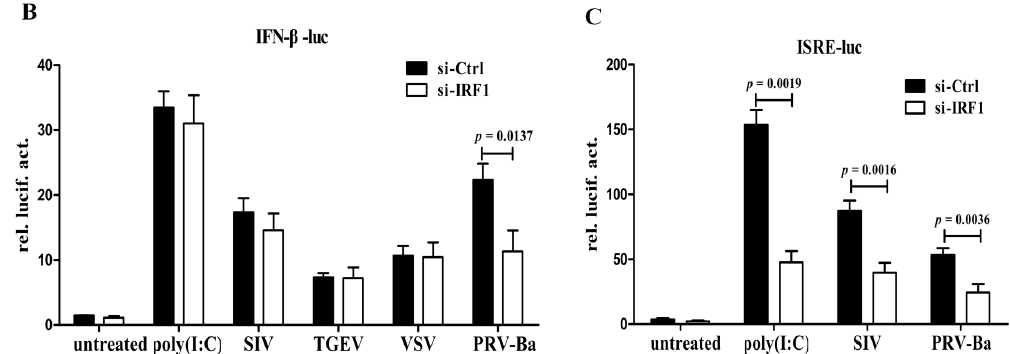
Figure 4. poIRF1 might be dispensable for IFN- β induction triggered by RNA viruses but essential for the activation of ISRE. ( A ) The effect of poIRF1 overexpression on activation of IFN- β and ISRE promoter. PK-15/PB and PK-15/IRF1 cells were cotransfected with indicated promoter constructs (0.5 µg) and pRL-TK (0.025 µg). At 24 h post-transfection, cells were transfected with poly(I:C) for another 24 h or left untreated and then harvested for detection of IFN- β and ISRE promoter activity. For measuring poIRF1-mediated induction of IFN- β , RT-qPCR was used to detect the transcription of endogenous IFN- β .The relative expression was normalized to the expression of GAPDH and expressed as fold induction relative to the expression level in control cells. Error bars represent SDs, which were obtained by measuring each sample in triplicate; ( B , C ) The effect of poIRF1 knockdown on activation of IFN- β and ISRE promoter. PK-15 cells were transfected with si-IRF1 or si-Ctrl for 36 h. Then, cells were cotransfected with IFN- β -luc or ISRE-luc and pRL-TK. At 24 h post-transfection, cells were transfected with poly(I:C) or infected with indicated viruses for another 12 h or left untreated and then harvested for detection promoter activity of IFN- β ( B ) or ISRE ( C ).